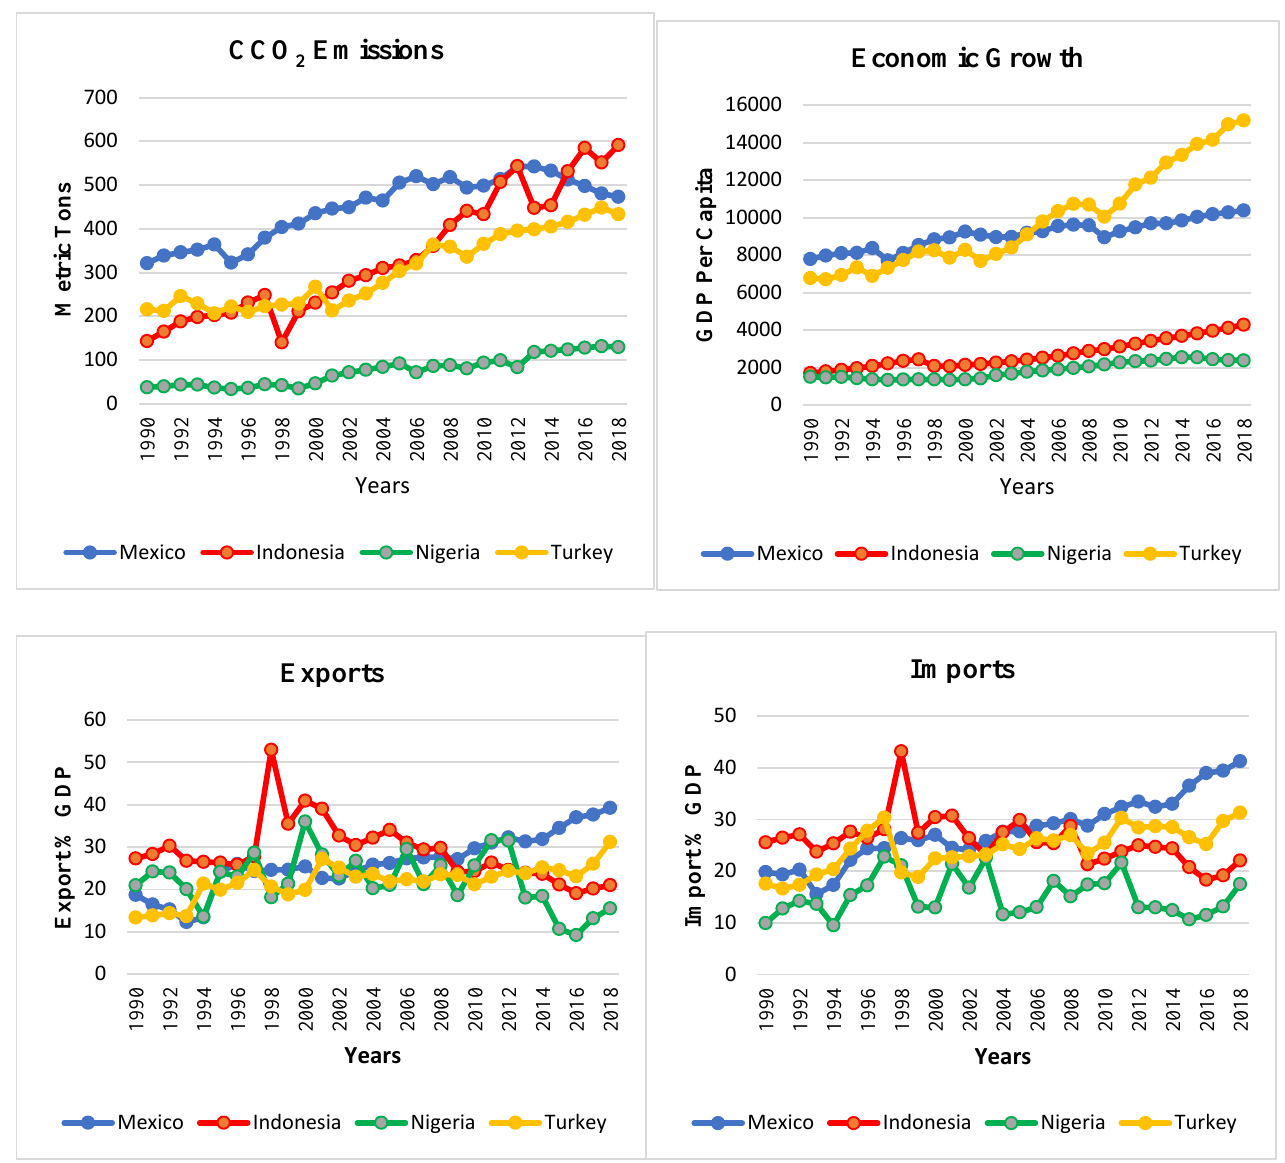
Table 2. Data description.